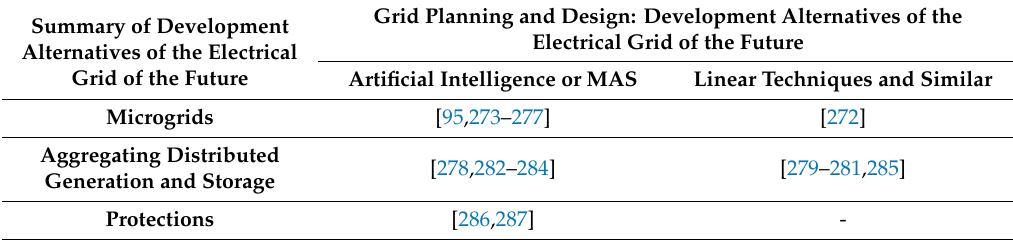
Table 13. Summary of Development Alternatives of the Electrical Grid of the